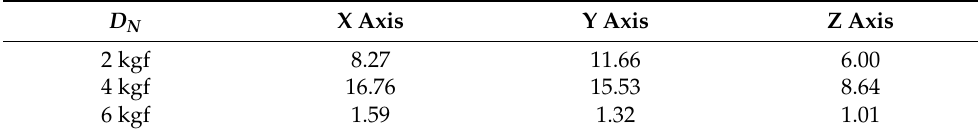
Table 6. DNF Number of axis X, Y, and Z from Sensor 1 of doctor blade tilting